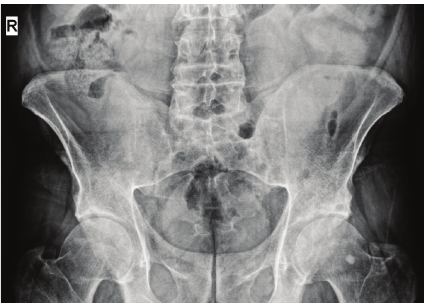
If we take into account the epidemiological and etiopath- ogenetic features of both diseases, NF1 is an autosomal- dominant disease that occurs in 1 out of 3,000 births. It is